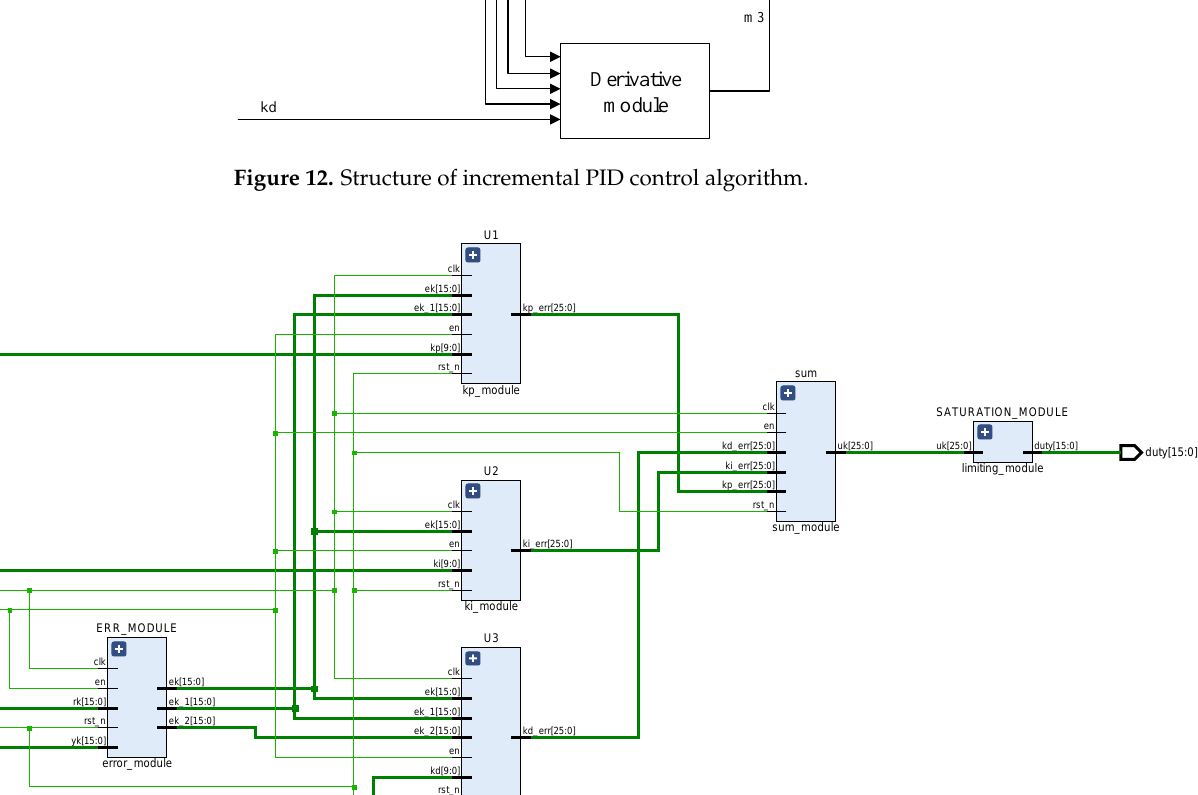
Figure 13. RTL schematic of incremental PID control